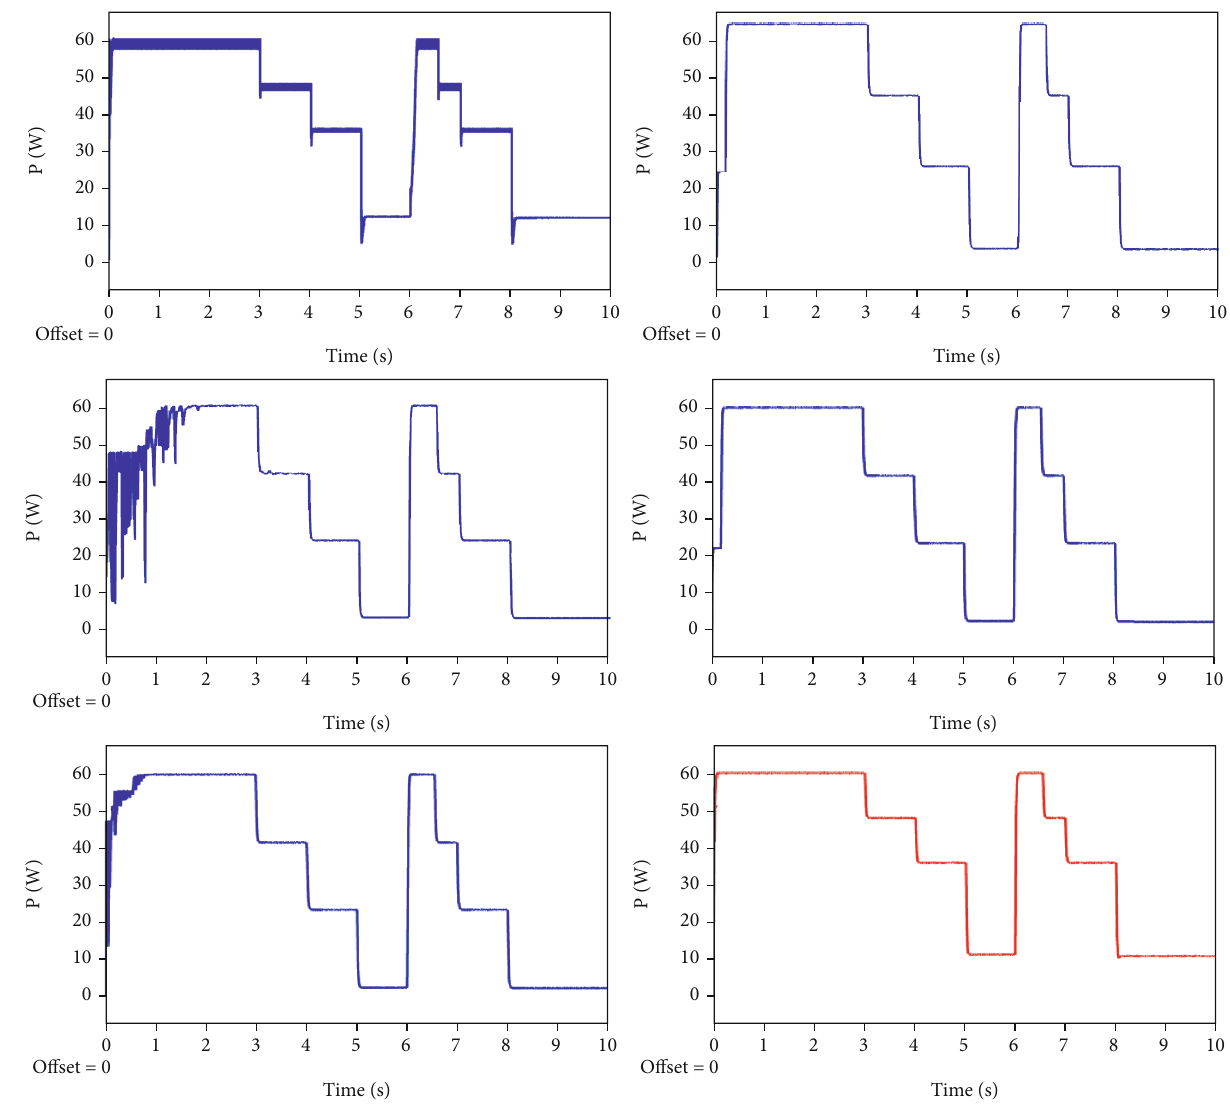
Figure 8: Simulation waveforms at the rapid change in insolation. PV array output power P&O, PSO, CUCKOO, GWO, WOA, and SMC-